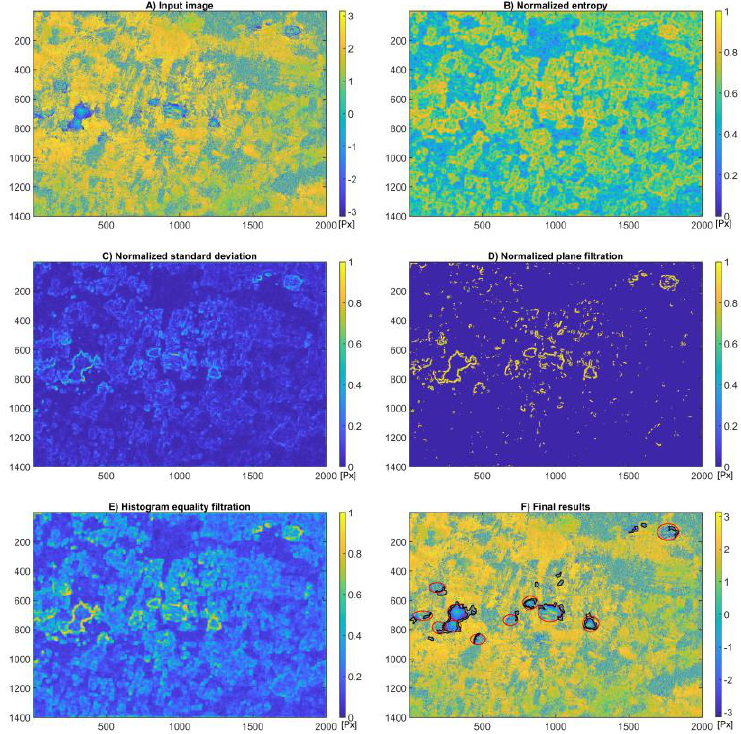
Figure 10. Example of trough detection algorithm with a special focus on the results of particular algorithm operations. The interferogram was computed for radar images recorded on 10 October 2016 and 22 October 2016 for the area of the Upper Silesian Coal Basin, Poland (Sentinel-1A, de- scending).